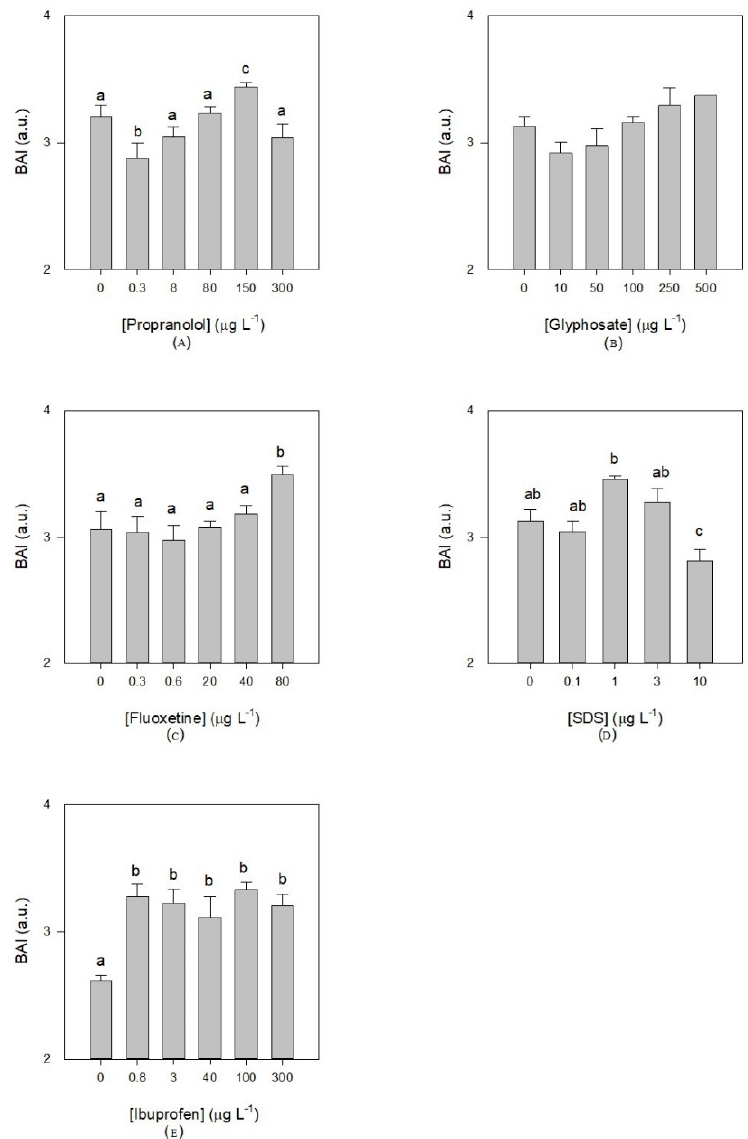
Figure 4. Bioeffect assessment index (BAI) of Phaeodactylum tricornutum cells exposed to different contaminants and concentrations. ( A ) Propranolol. ( B ) Glyphosate. ( C ) Fluoxetine. ( D ) SDS. ( E ) Ibuprofen. Average ± standard deviation, n = 3, different letters indicate significant differences at p <